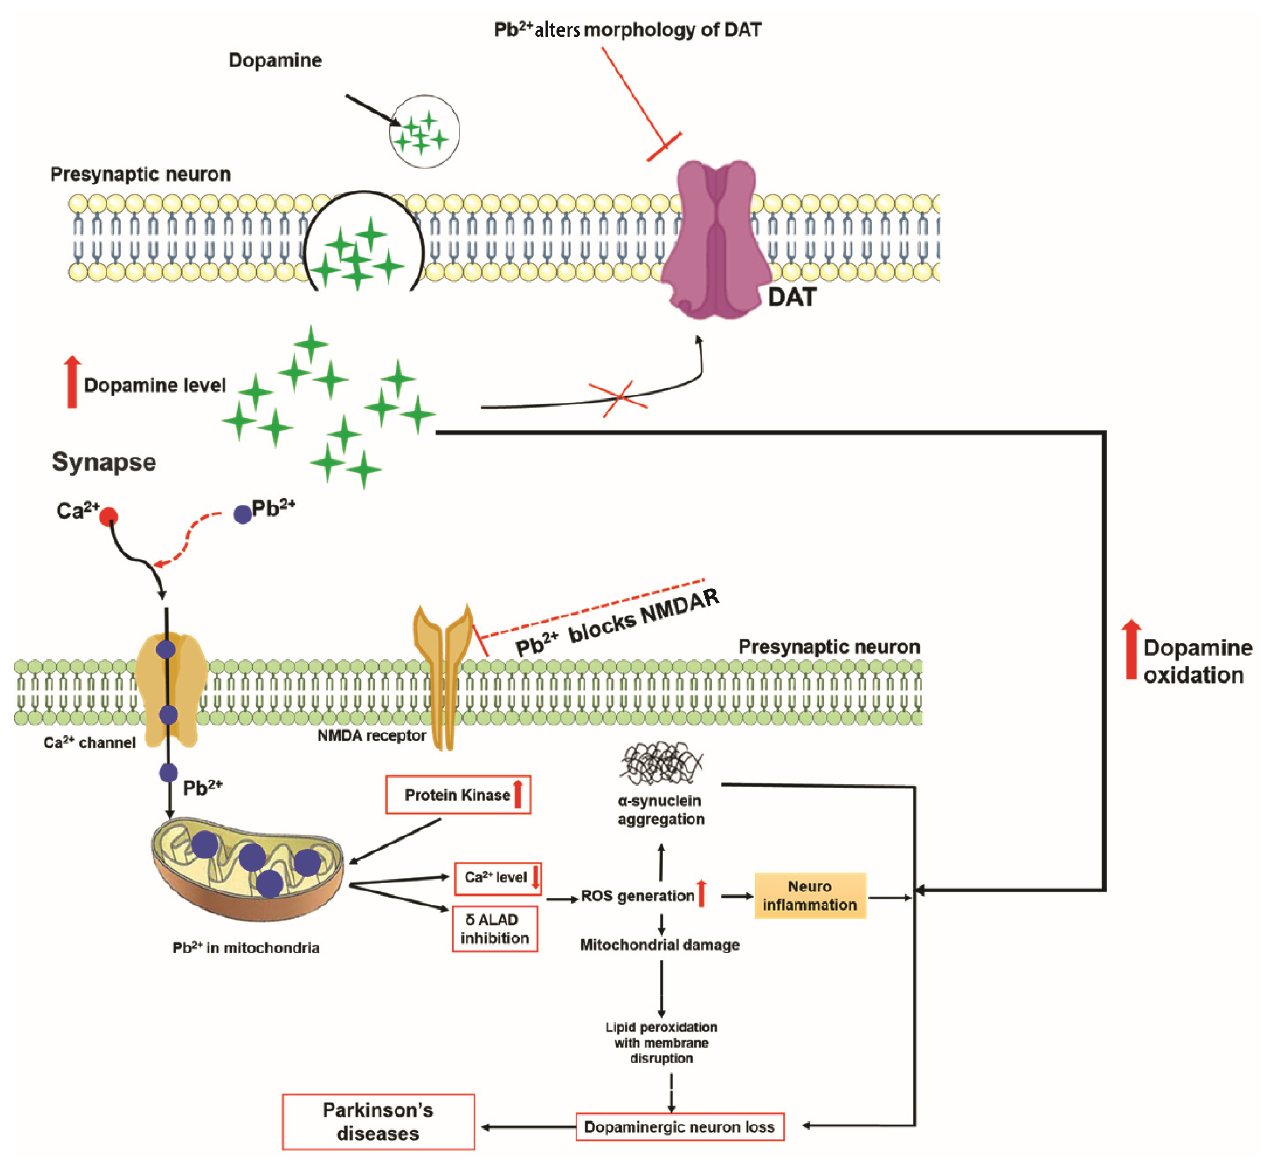
Figure 5. Pb 2+ induces changes in dopamine transporter (DAT) morphology, leading to an increase in extracellular dopamine level, resulting in neurotoxicity via dopamine oxidation. Moreover, Pb 2+ and Ca 2+ share a permeability pathway represented by a Ca 2+ channel and increased Pb 2+ level in mitochondria, causing dopaminergic neuron loss. In addition, Pb 2+ induces α -synuclein aggregation, NMDA receptor (NMDAR) blockade, and the activation of protein kinase C, leading to reduced Ca 2+ release from mitochondria. Moreover, δ -aminolevulinic acid dehydratase ( δ -ALAD) blockade by Pb 2+ delivered by mitochondria leads to the initiation of lipid peroxidation. These mechanisms ultimately cause the depletion of dopaminergic neurotransmission resulting in the development of PD.